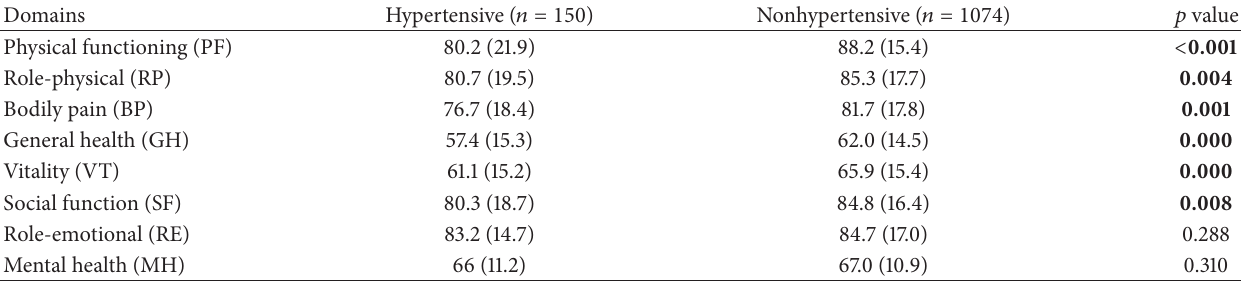
Table 2: Descriptive statistics of each domain of the SF-36 among adults in Chongqing, China (mean,